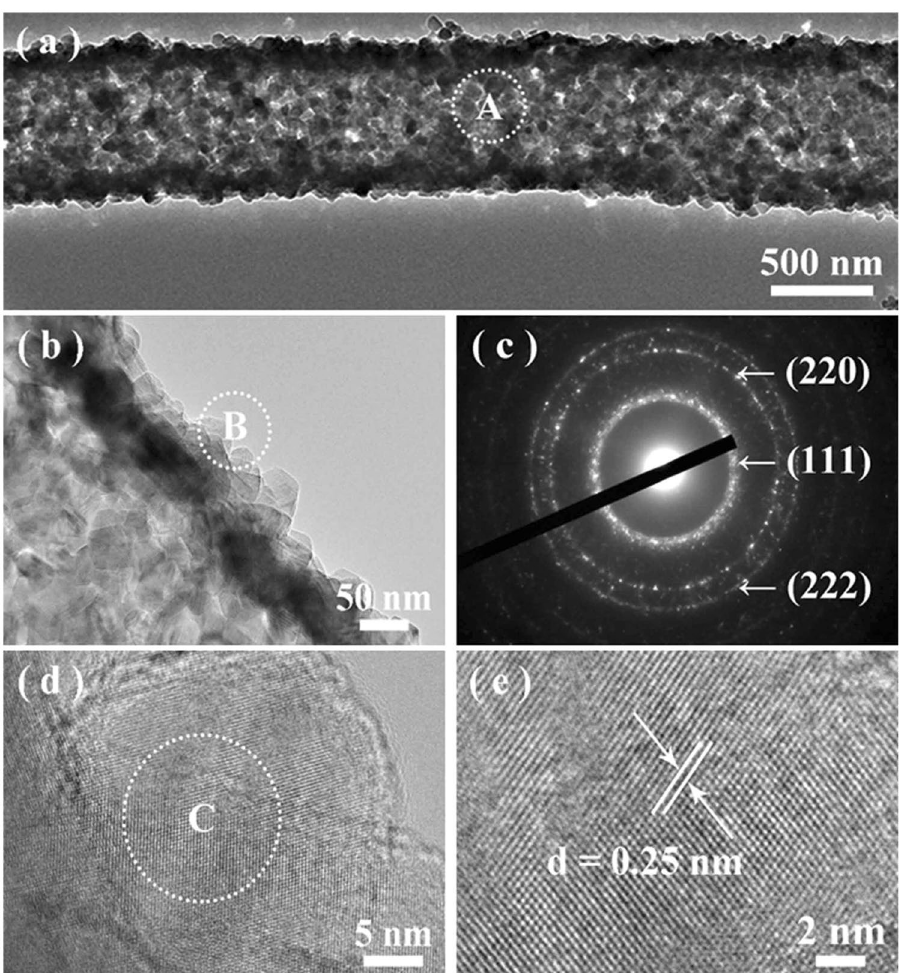
Figure 3. ( a and b ) Typical TEM images of a single follow SiC fiber from Sample E under different magnifications. ( c ) A typical SAED pattern recorded from the marked area of A in part a. ( d ) Typical HRTEM image obtained from a single nanoparticle recorded from the marked area of B in part b. ( e ) An enlarged HRTEM image recorded from the marked area of C in part